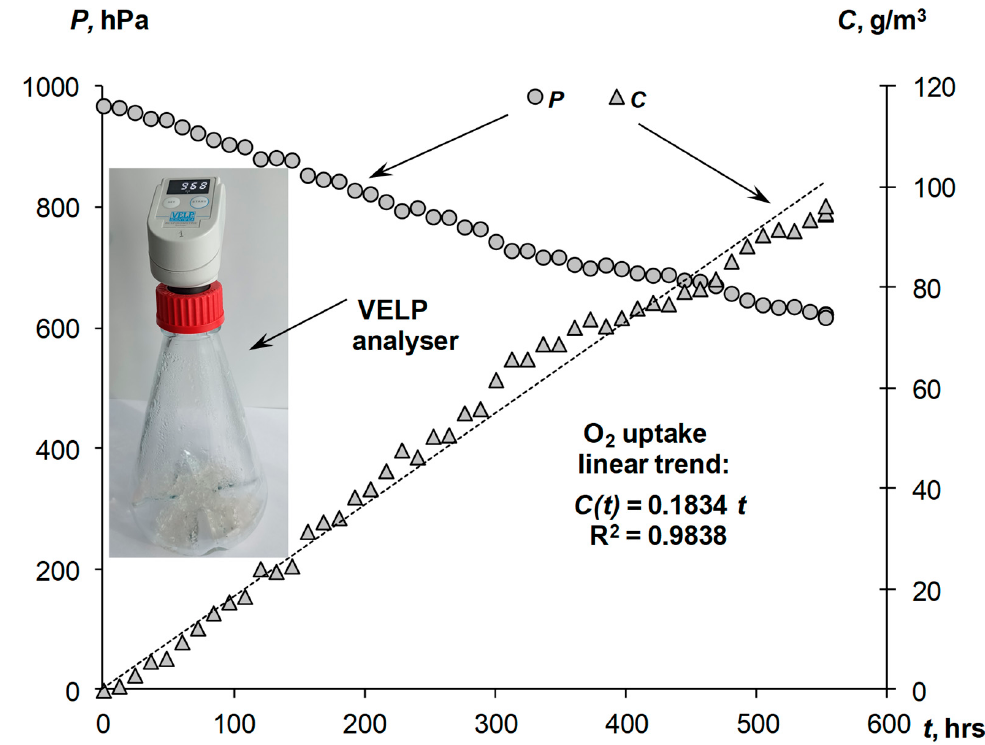
Figure 1. Experimental trend of pressure dynamics P ( t ) transformed according to Formula (11) into an oxygen uptake curve ( C ( t )) (main figure); the VELP Respirometer with the Aquasorb gel (inset photo).